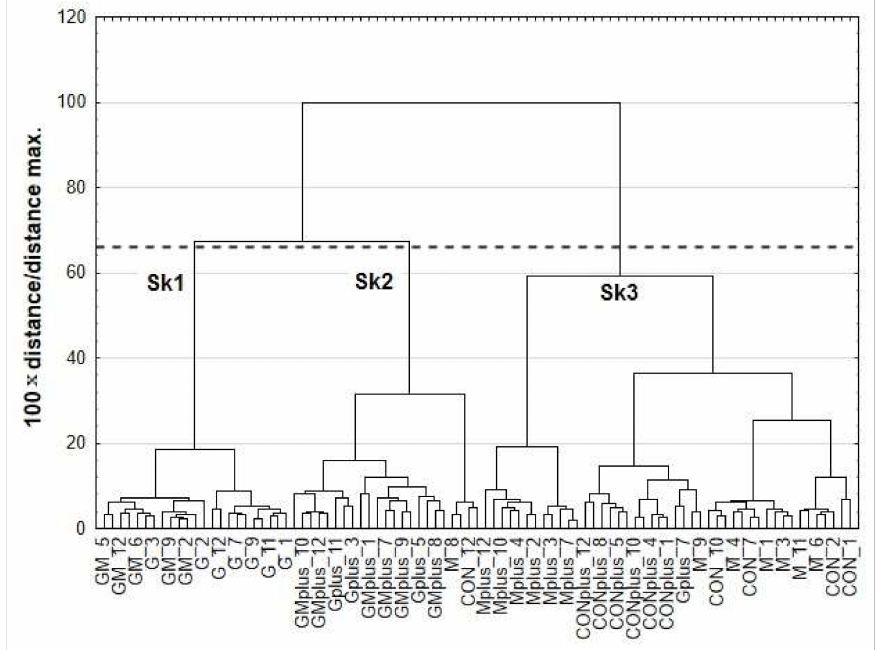
Figure 3. Dendrogram of similarities of FA and CFA profile in the microsomes of experimental groups. Similarity analysis was performed by using the method of grouping features and objects for fatty acids and CFAs differing significantly among clusters revealed in CA. This was applied to prepare a heat map (Figure 4) and clearly shows that serum samples of Sk1 were characterized by the highest share of most of CFAs (apart from ttc/ctt), c9c12c15C18:3, c9c11C18:2 and c5c8c11c14c17C20:5, as well as the lowest share of c11C18:1, c15C24:1 and c4c7c10c13c16c19C22:6. In microsomal samples included in Sk2, the highest amounts of most of the examined fatty acids were detected apart from c9c12c15C18:3, c9c11C18:2 and ttt. For Sk3, low levels of most examined CFAs and fatty acids were distinctive.